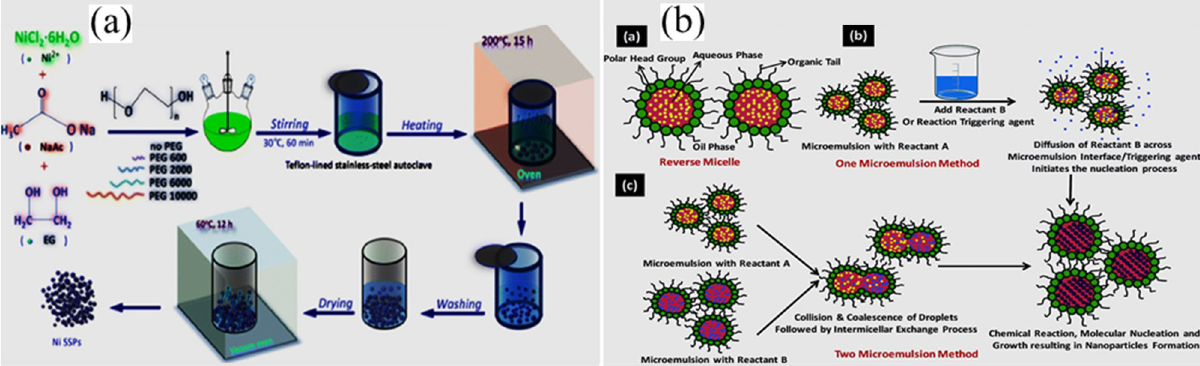
Figure 9: Schematic diagram of ( a ) polyol [ 105 ] , and ( b ) microemulsion solvothermal [ 106 ] synthesis of